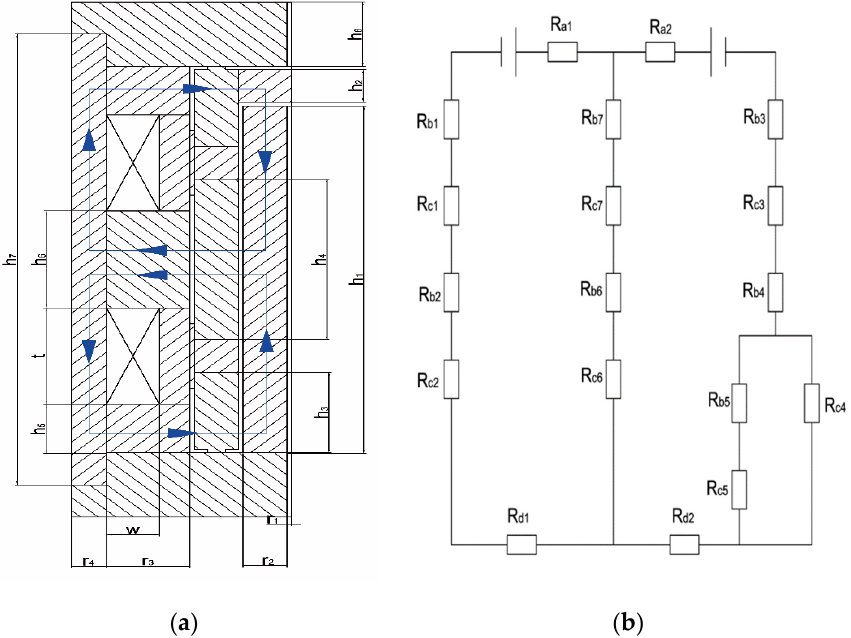
Figure 4. Magnetic circuit of annular multi-channel MR valve: ( a ) magnetic circuit diagram and ( b ) equivalent magnetic circuit diagram. Table 2. Dimension parameters of annular multi-channel MR valve parameter.